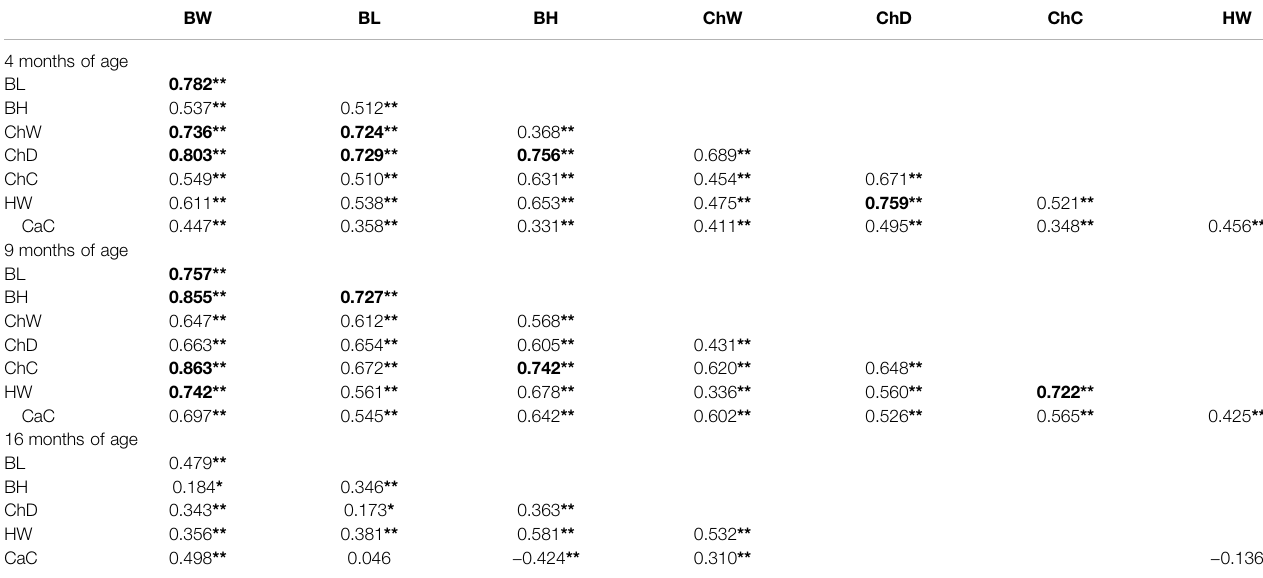
TABLE 2 | Correlations between growth traits of Hulun Buir sheep a